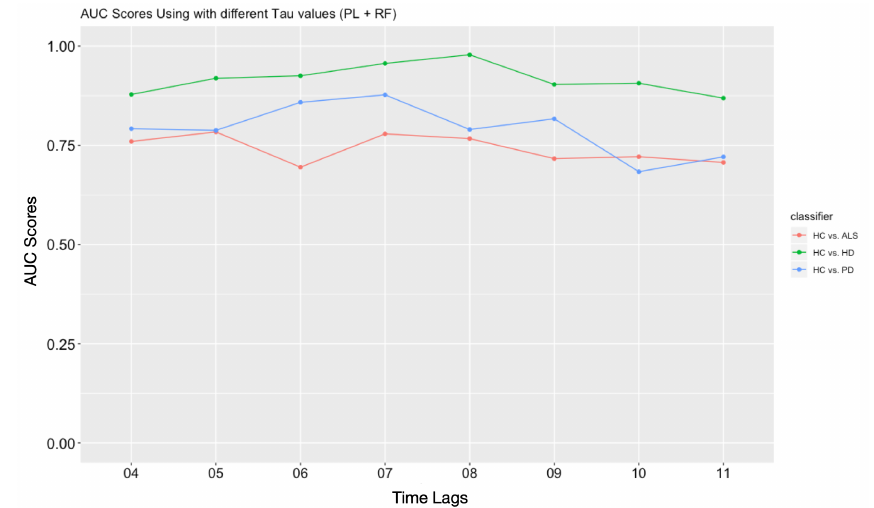
Figure 14. The AUC scores of the wholistic system using different time lag parameters in generating topological featurs.